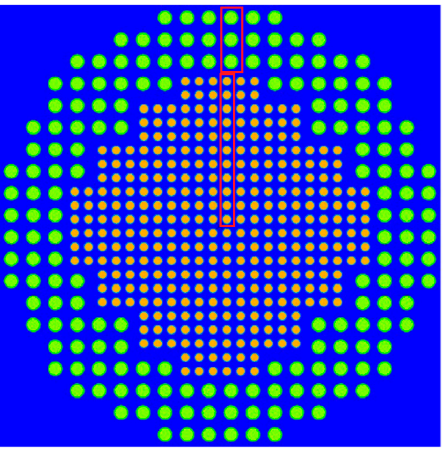
Figure 9. Radial section of the CROCUS reactor obtained with TRIPOLI-4 ® . The inner fuel rods (UO 2 , orange) and the outer fuel rods (metallic U, green) are moderated by light water (blue). The red regions denotes the 14 fuel rod positions defined for the flux distribution [15].